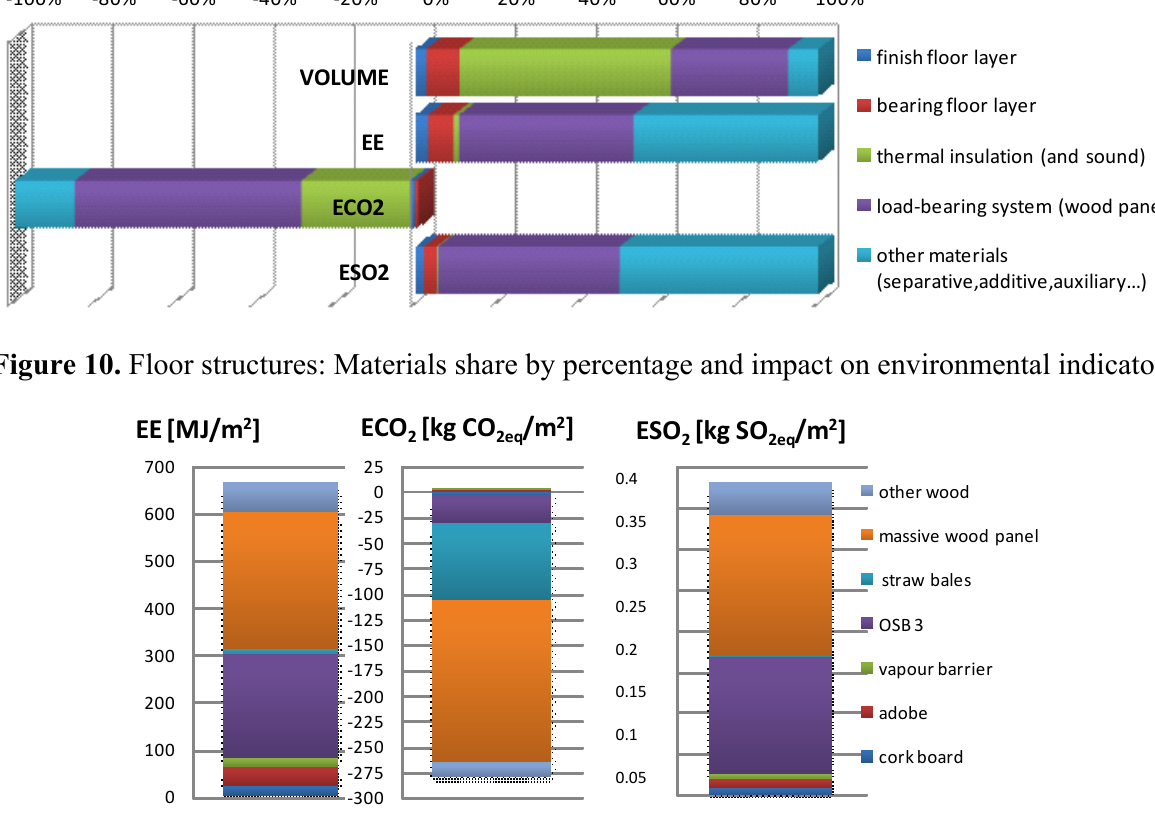
Figure 11. Floor structures: Impact of materials on environmental